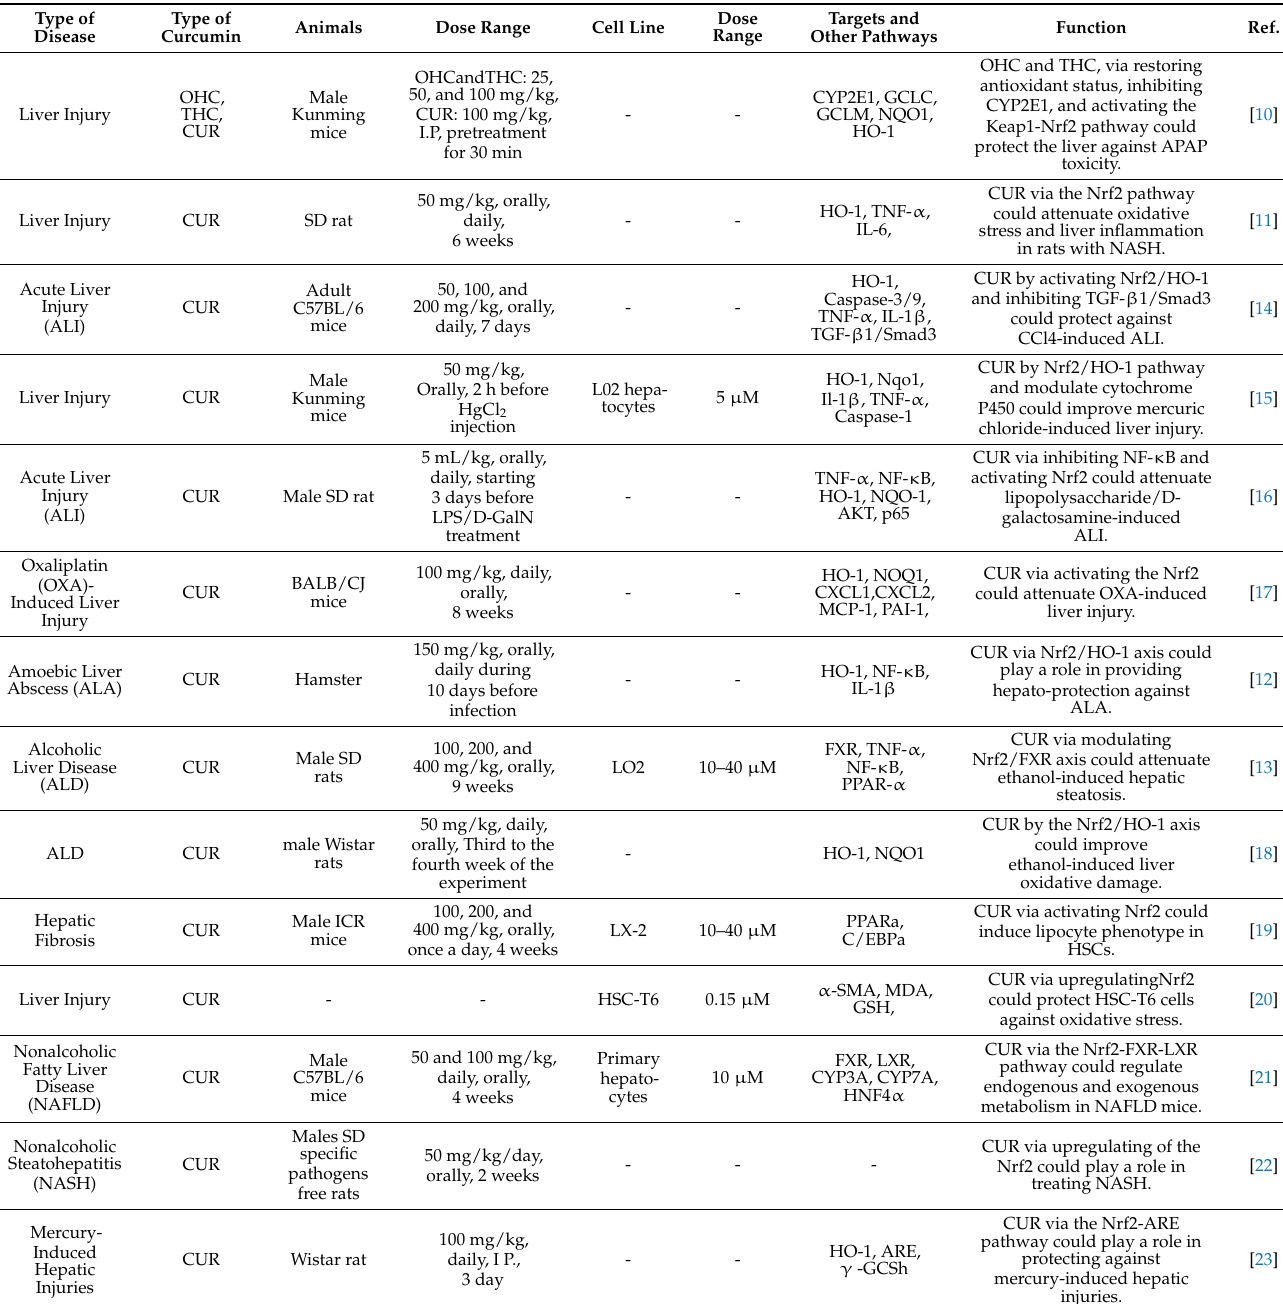
Table 1. Nrf2-related therapeutic effects of curcumin in gastrointestinal diseases (I.P.: